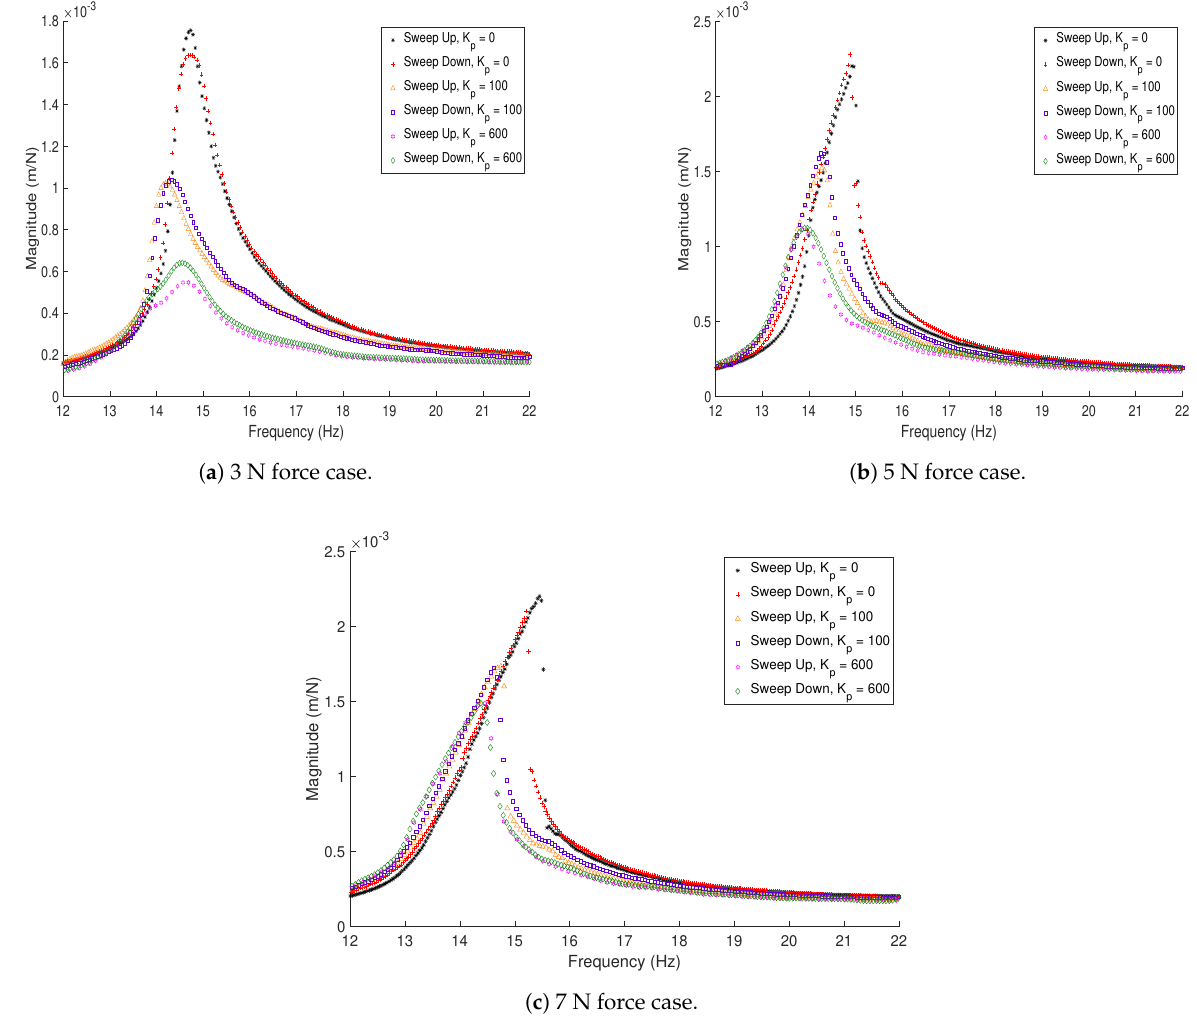
Figure 7. The response of the structure subject to both decreasing and increasing excitation frequencies for selected cases of proportional gain values for ( a ) 3 N of force, ( b ) 5 N of force, and ( c ) 7 N of